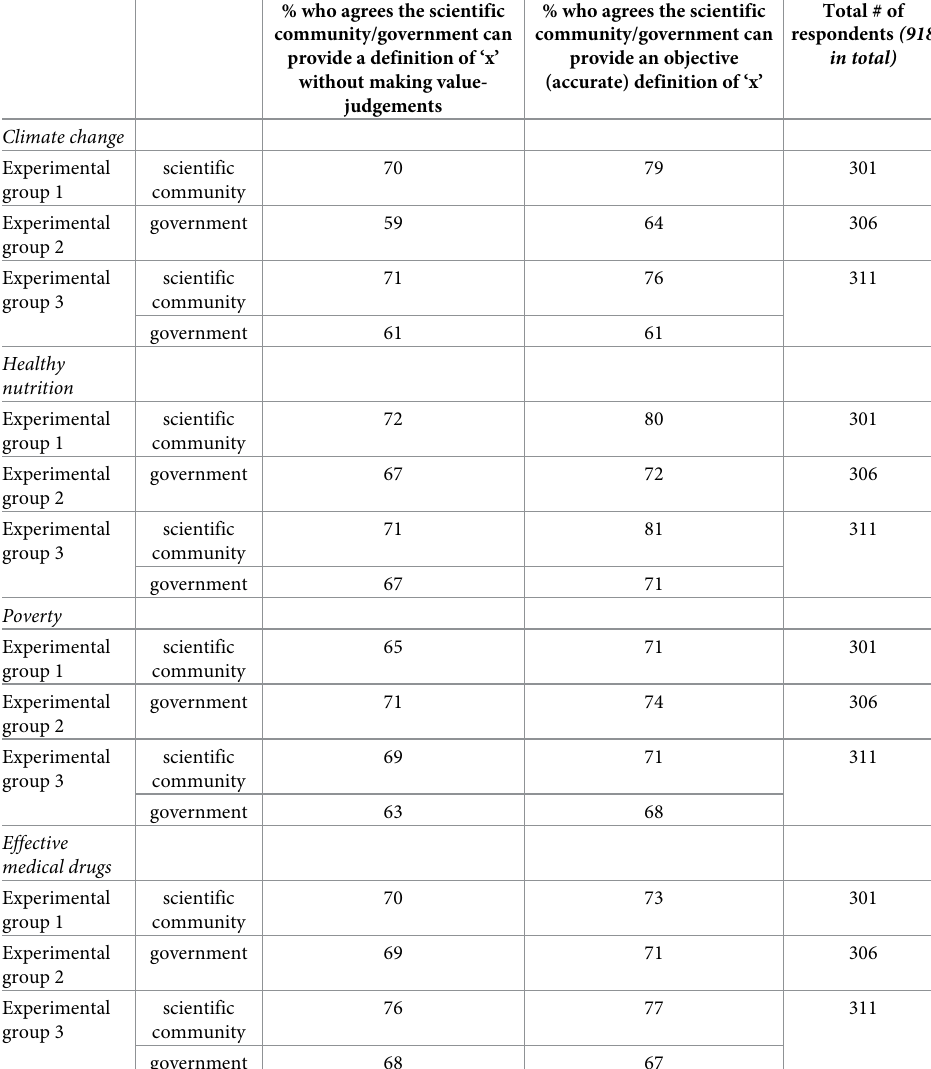
Table 4. Share of people who agrees that the scientific community and government can provide a value-free or objective definition of climate change, healthy nutrition, poverty and effective medical drugs.